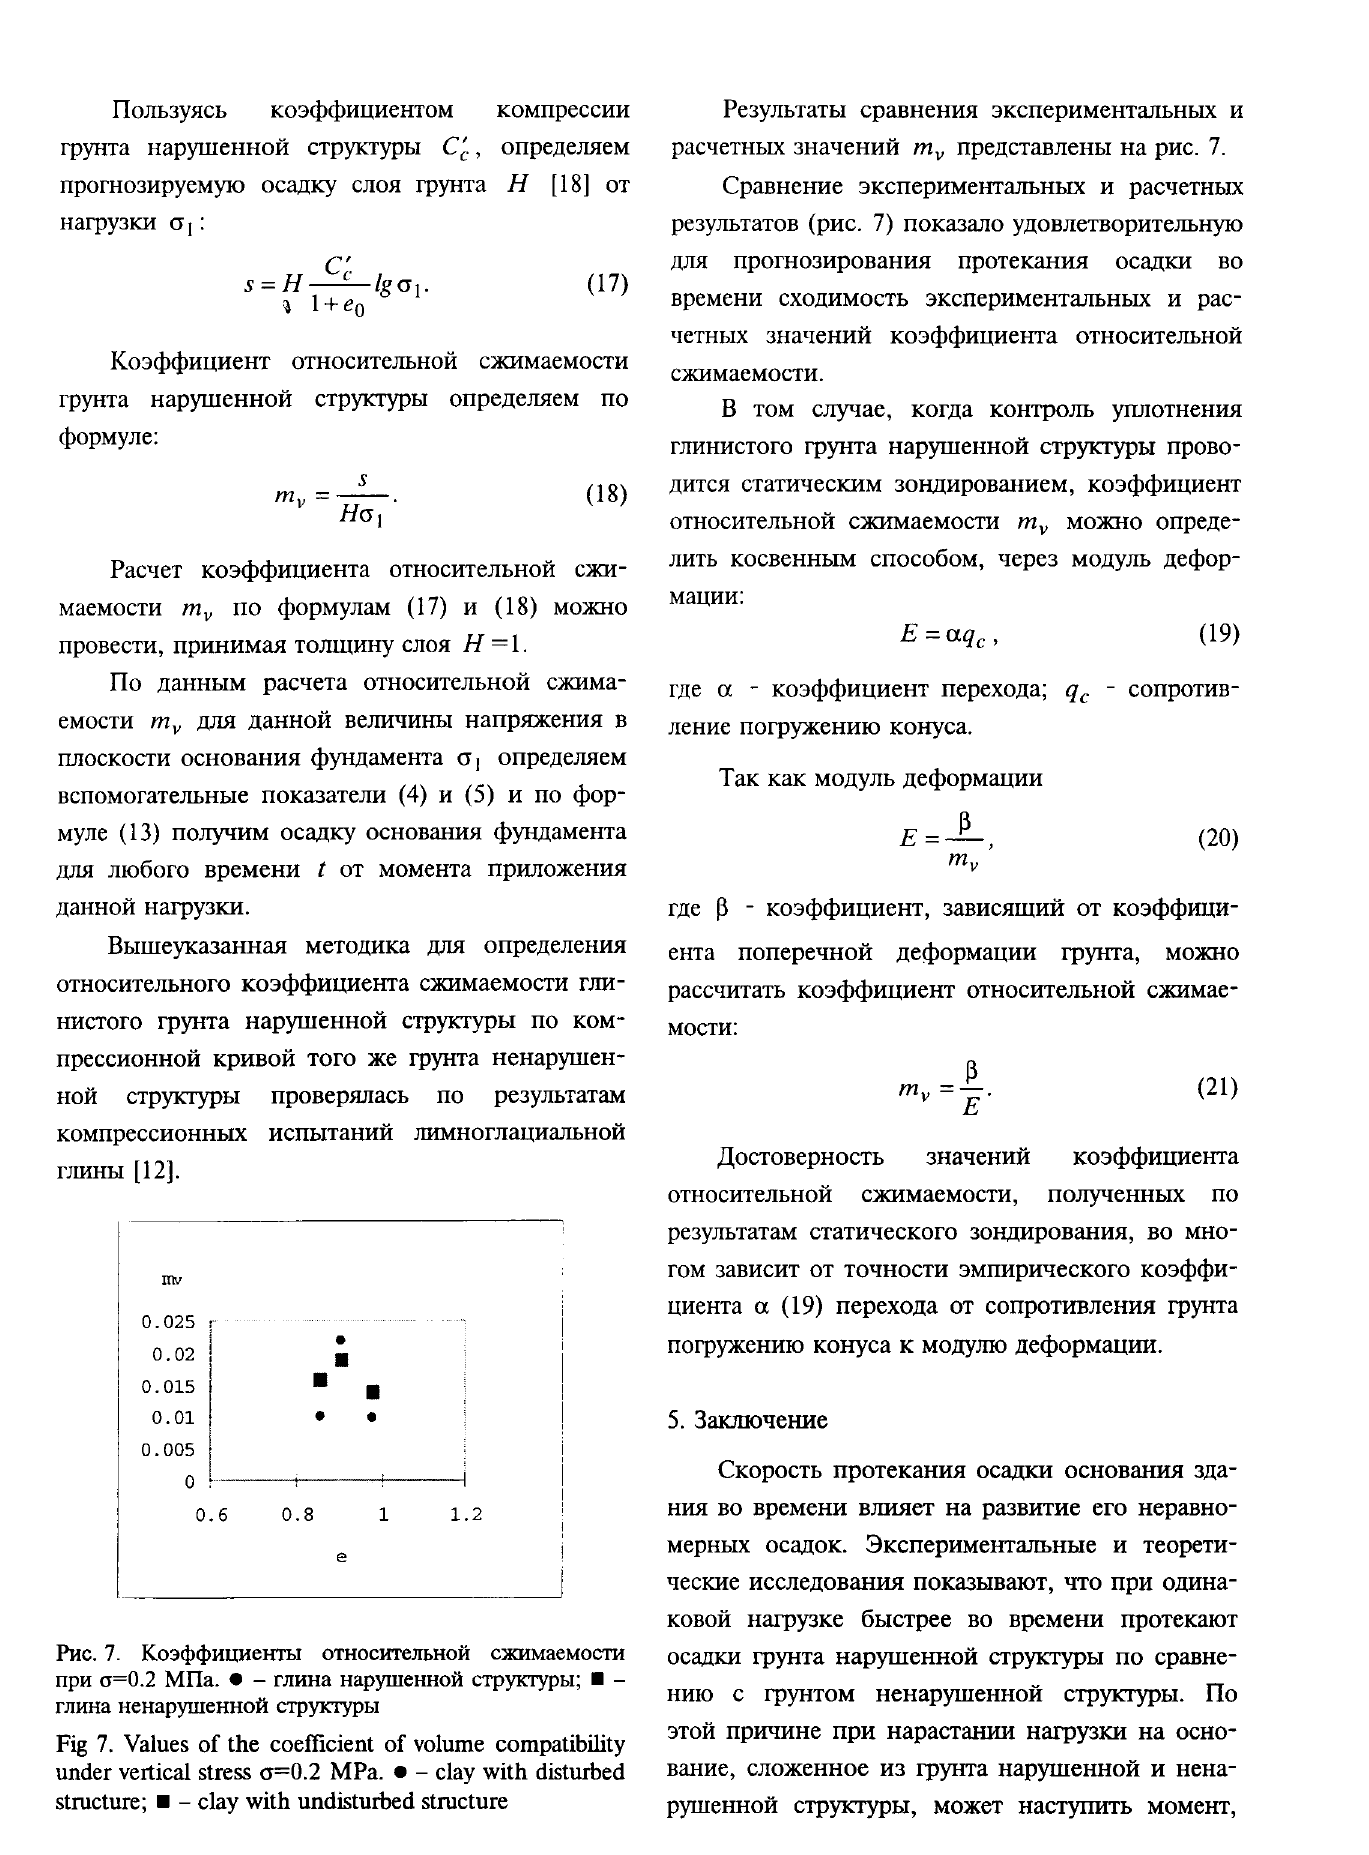
Fig 7. Values of the coefficient of volume